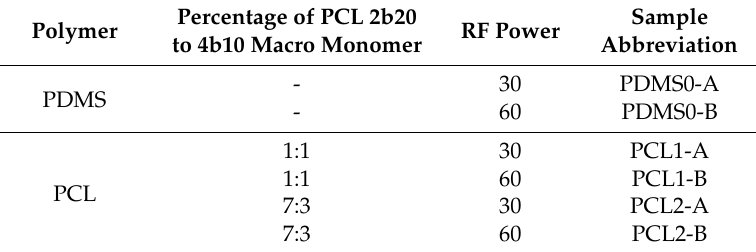
Table 1. Sample abbreviation at different RF